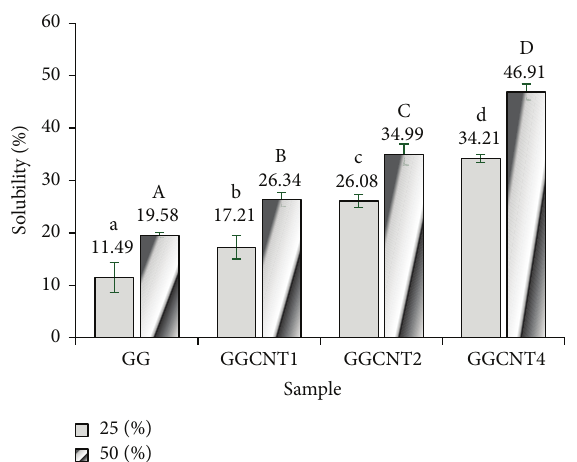
Figure 2: Diffractograms of films from gelatin/glycerol and car- bon nanotubes. (a) GG and (b) GGNTC1; (c) GGNTC2 and (d)